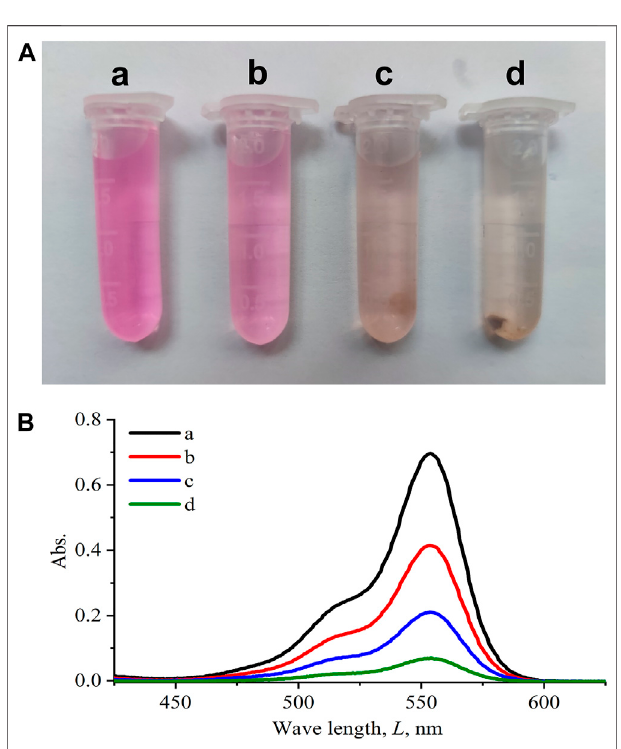
FIGURE6| Removaloforganic pollutants from aqueous solutionsusing Janusmicrorobots. (A) Photographsofasolution with10 mg/LRhodamineB after 5 min of treatment with equivalent amounts of pure water SiO 2 (a) , SiO 2 microspheres (b) , Janus microrobots without a magnetic fi eld, and (c) Janus microrobots with a magnetic fi eld (d) . (B) Absorbance spectra of Rhodamine B ( C 0 = 10 mg/L) after 5 min of treatment associated with Figure 6A